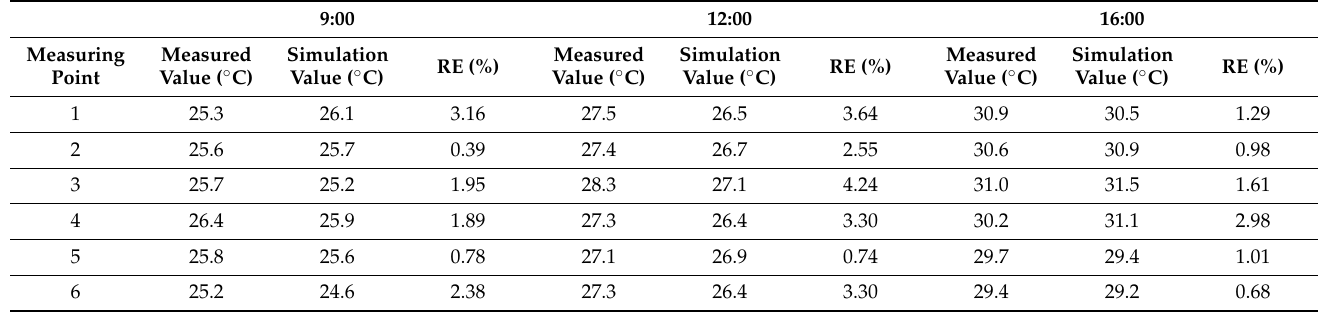
Table 4. Comparison of air temperature between the measured value and the simulation value.